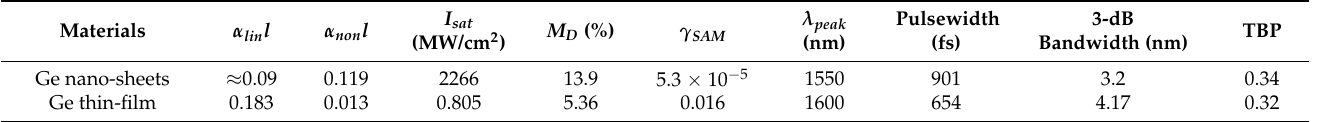
Table 3. Comparison of the nonlinear absorption and mode-locking parameters for the Ge SA and Ge nano-sheet